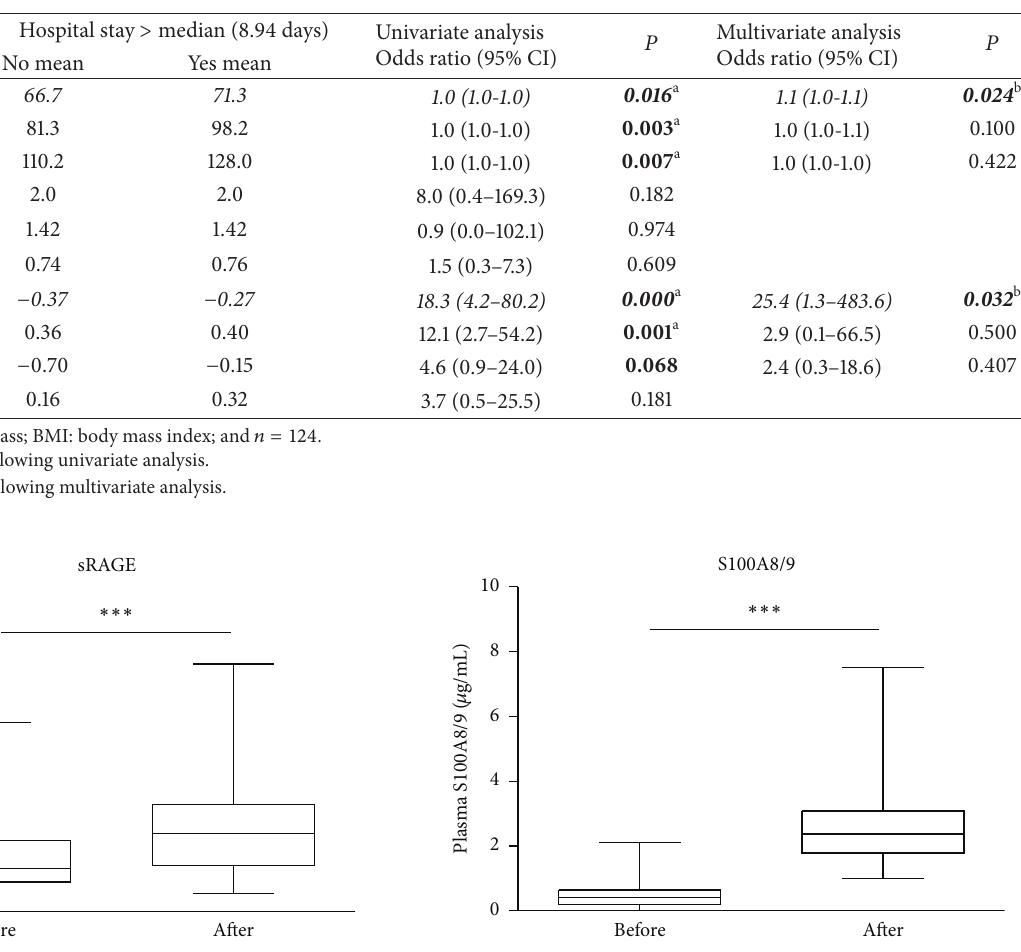
Figure 1: Plasma levels of sRAGE increased 2h after surgery necessitating cardiopulmonary bypass compared with preoperative levels. Data presented as bar graphs with median and 75th percentile concentrations of sRAGE indicated 𝑛 = 129 , ∗∗∗ 𝑃 < 0.001 .